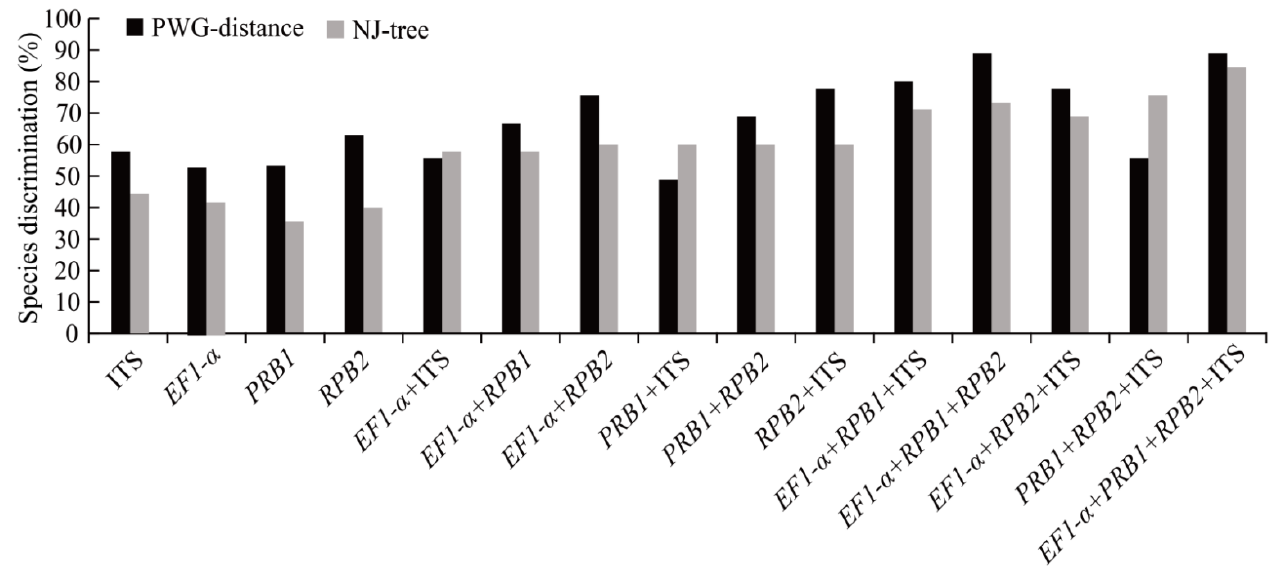
Figure 3. Statistics of species discrimination rates based on PWG-distance and NJ-tree methods. Histograms of the frequencies ( y -axes) of the species discrimination rate based on PWG-distance and tree-building; x -axes represent 4 single- and 11 multi-locus barcodes in Morchella . The black bars express the resolution rate based on the PWG-distance approach, and the gray bars show the recognition power according to tree-building method.